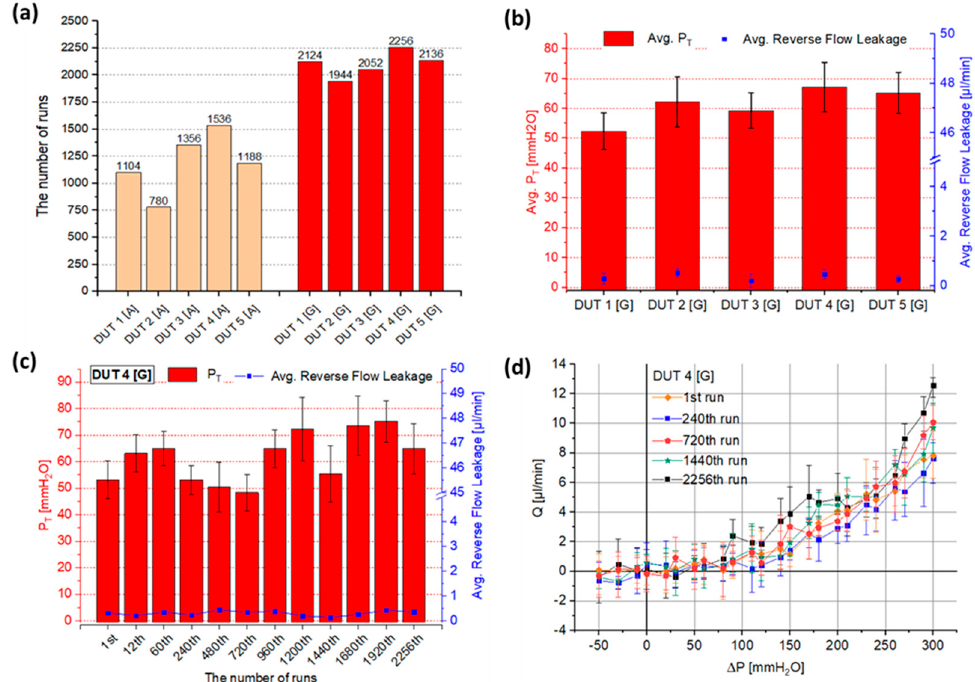
Figure 7. Automated repetitive tests were performed by a programmable peristaltic pump to evaluate the valve’s long-term functionality. In order to enhance the reliability and durability of the valve, glass was used for the surrounding substrate instead of the acrylic plate because glass has higher adhesion strength than acrylic due to its superior hydrophilicity. One cycle consists of flow response measurements in forward and reverse flow and is analogous to a one-day operation of the valve [20]. ( a ) Comparison of the automated repetitive test results between acrylic-based (DUT [A]) and glass-based devices (DUT [G]). The results of the acrylic-based devices (DUT [A]) are referenced from our previous study [19] for comparison purposes. The 4 out of the 5 devices with glass surrounding substrate (DUT 1[G], 3[G], 4[G], and 5[G]) marked much higher run cycles, >2000. Generally, glass-based devices display ~50% higher running times than acrylic-based devices. ( b ) The average value of P T and reverse flow leakage of the devices during the repetitive tests. The devices show P T and reverse flow leakage in the range of 52.3~67.1 mmH 2 O and < 0.5 μ L/min, respectively. Error bar: standard deviation. ( c ) P T and reverse flow leakage of DUT 4[G] over 2256 cycles. The measurements show the valve functions consistently at 48.3 < P T < 75.1 mmH 2 O and reverse flow leakage of < 0.3 μ L/min. Error bar: standard deviation. ( d ) The flow response of the valve (DUT 4[G]) shows high diodicity behavior with negligible reverse flow leakage throughout 2256 runs. Error bar: min to max.